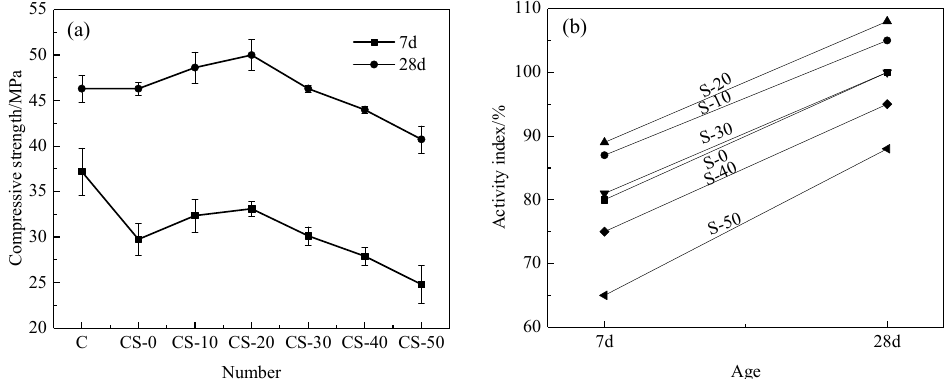
Figure 7. Compressive strength of mortars and activity index of slag-tailing admixture: ( a ) Compressive strength of mortars; ( b ) activity index of slag-tailing admixture.